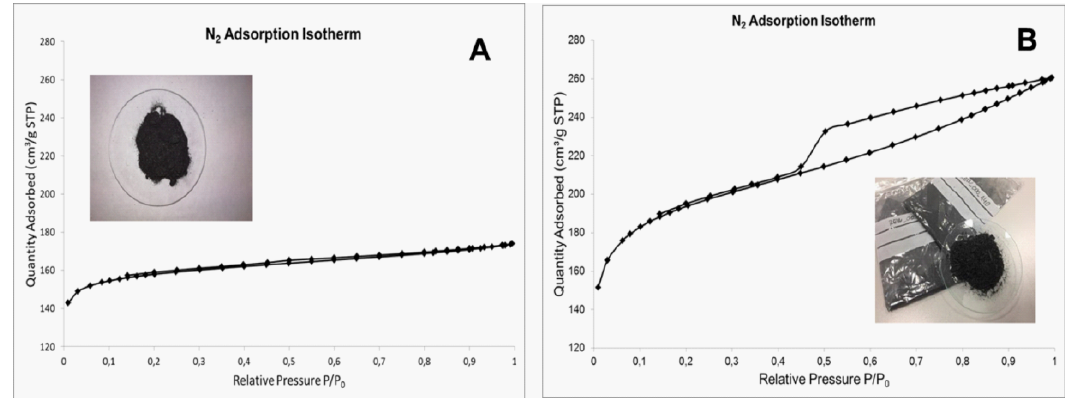
Figure 1. N 2 adsorption isotherm for the activated carbon: ( A ) derived from sawdust; ( B ): derived from pruning remains.